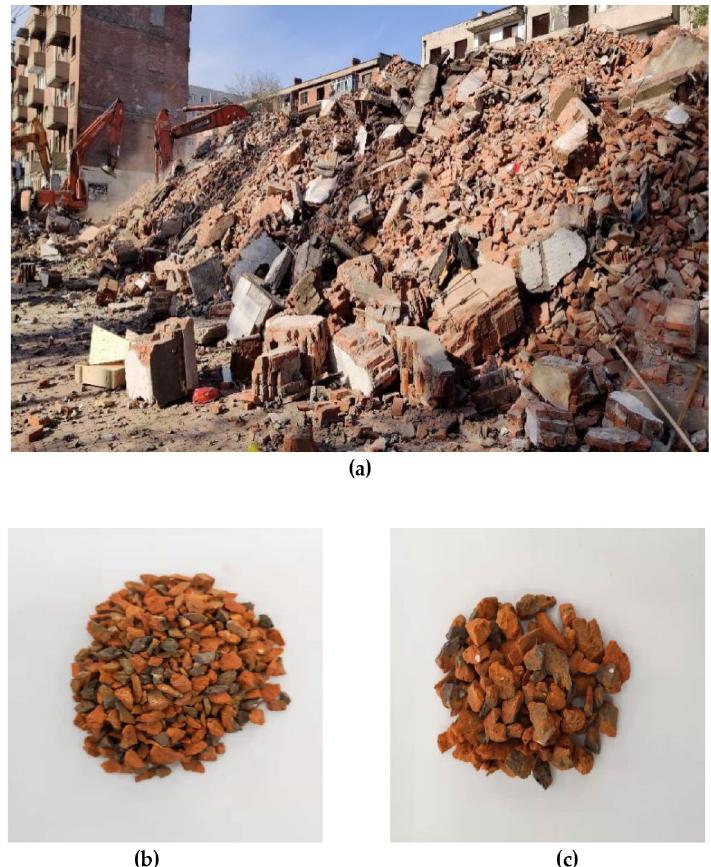
Figure 1. Red brick aggregate: (a) Red brick fetching site; (b) 5 ~ 10 mm particle size; (c) 10 ~ 20 mm particle size.